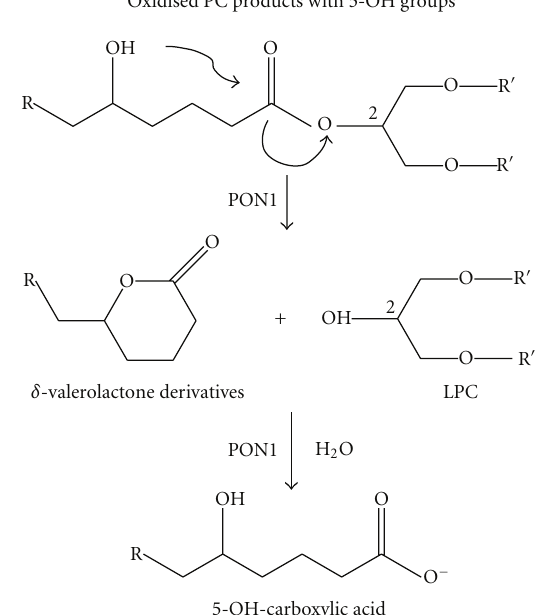
Figure 4: Proposed mechanism for the hydrolysis of oxidized lipids in macrophages by PON1 to yield lysophosphatidylcholine. Oxidized lipids with hydroxyl groups at the 5 (cid:2) position could be lactonized by PON1 to yield lysophosphatidylcholine and the cor- responding δ -valerolactone products. The latter can be hydrolyzed again by PON1 to yield the corresponding 5-hydroxycarboxylic